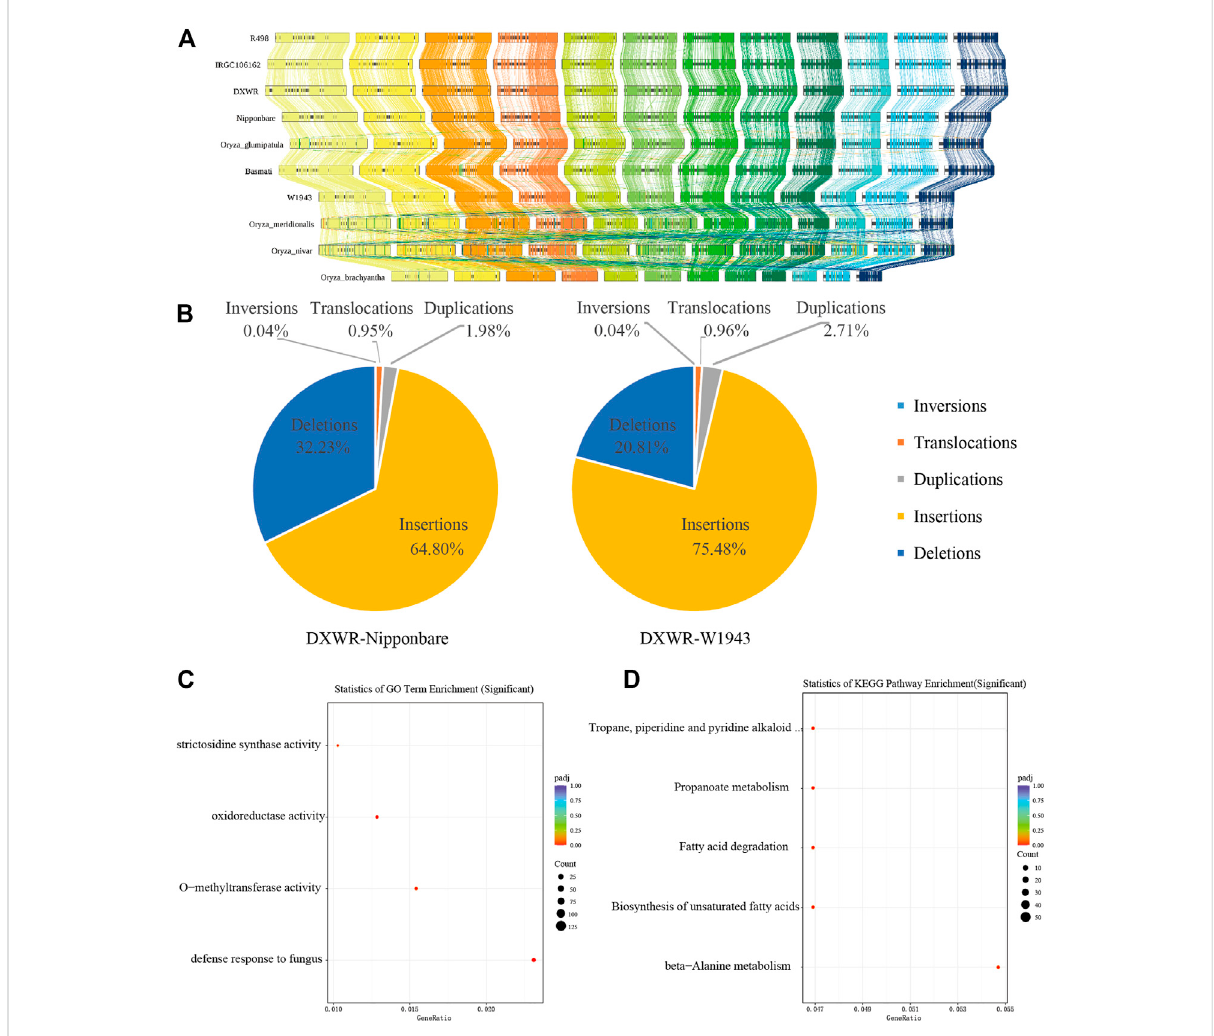
FIGURE 5 ThegenomicvariationsofDXWR. (A) Syntenyanalysisofgenesintencropsof Oryza genus. (B) ThestructurevariationofDXWRandNipponbare and W1943. The results of GO enrichment (C) and KEGG enrichment (D) analysis of genes involved in inversion in